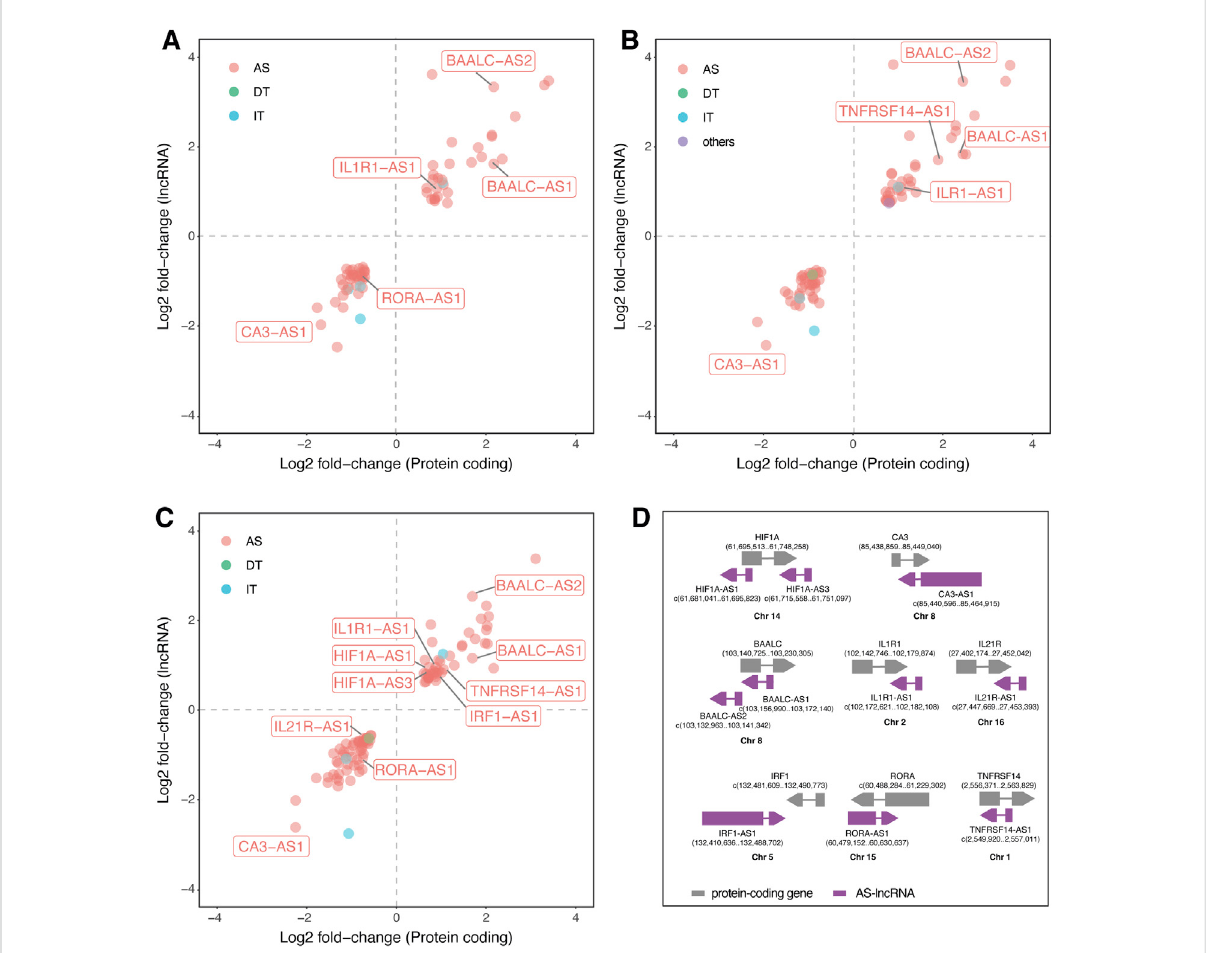
FIGURE 4 Coexpression of LncRNAs and mRNAs modulated upon Leishmania infection in THP-1 macrophages. Scatter plots represent the log2 fold- changevaluesdeterminedbyRNA-seqofproteincoding (Xaxis)and lncRNAs(Yaxis) of (A) L.amazonensis -infected (B) L.braziliensis -infected (C) L. infantum -infected macrophages; (D) illustrations representing the genomic position of 10 coregulated lncRNA-mRNA pairs, in which grey represents protein-coding gene, purple represent AS-lncRNA and the numbers depict genomic position in the sense and antisense complementary DNA strand. AS: antisense; DT: divergent transcript; IT: intronic transcript; Chr: